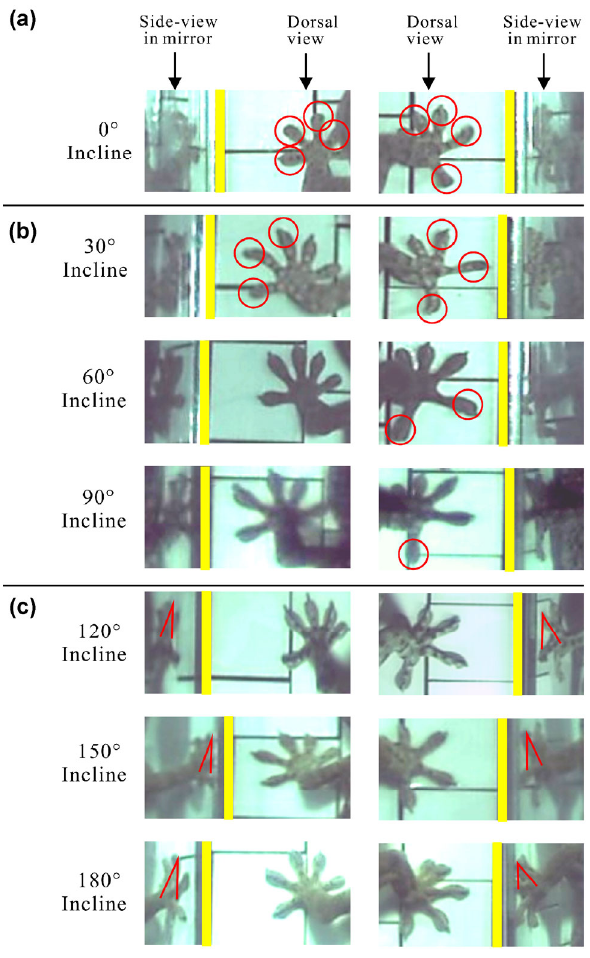
Fig. 3 Foot contact with the substrate during a stable period of contact ( T SPC ) for an incline of 0° to 180°. (a) Only the heel contacts the substrate. (b) Concomitant contact state involving both the heel and toe. (c) Toes contact the substrate while the heel is held away from the substrate. The state of the left front foot is shown in the left column of the figure, while the state of the right hind foot is shown in the right column of the figure. The red circle indicates that the toes are not in contact with the substrate. The red bevel indicates that the heel is not in contact with the